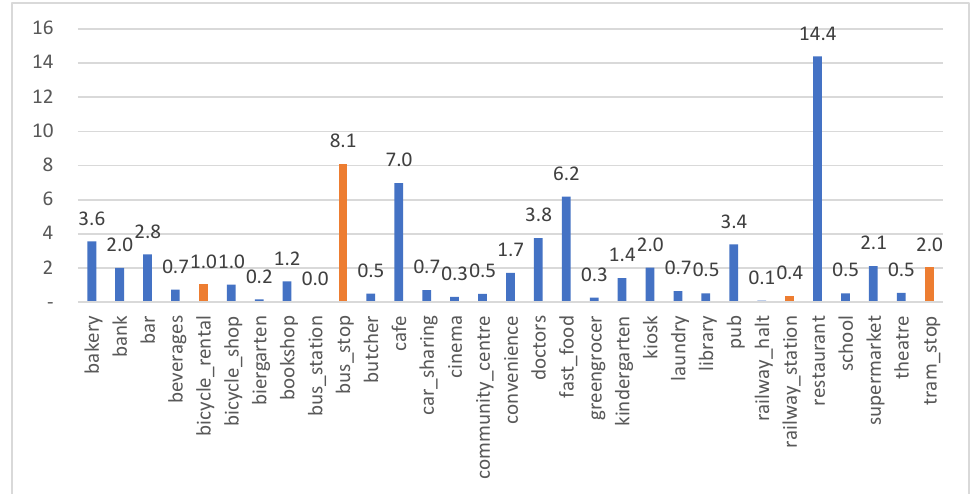
Figure 5. Average number of different POIs in the vicinity of 500 m in the surrounding of coworking spaces in peripheral and non-peripheral areas.